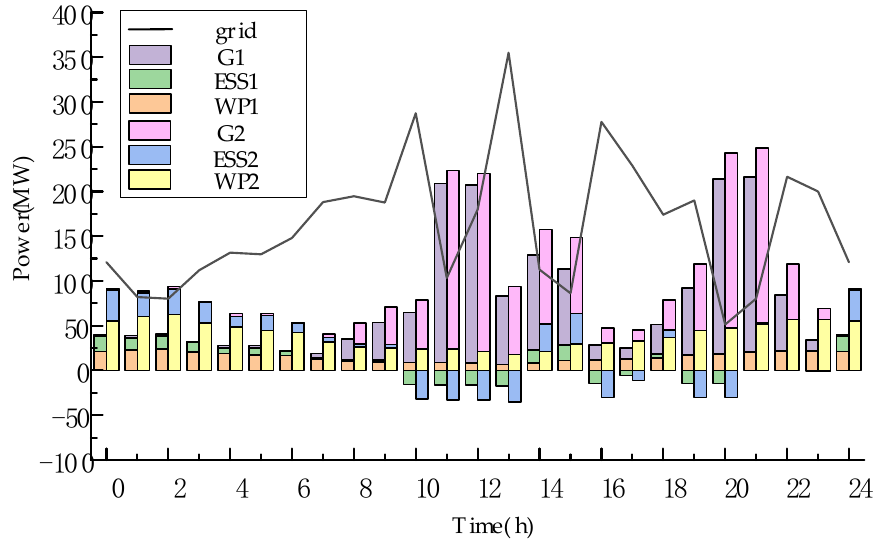
Figure 5. Power operation diagram under Scheme A.